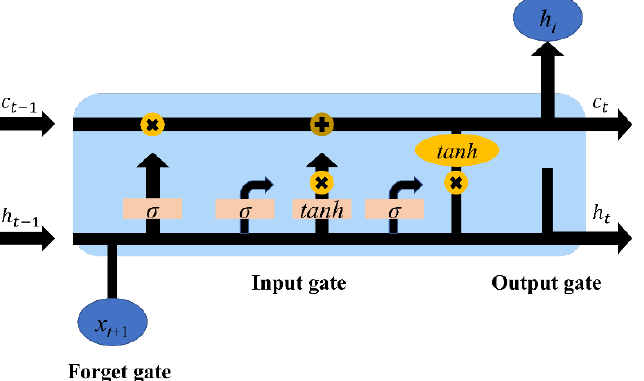
Figure 3. The schematic of the LSTM model.